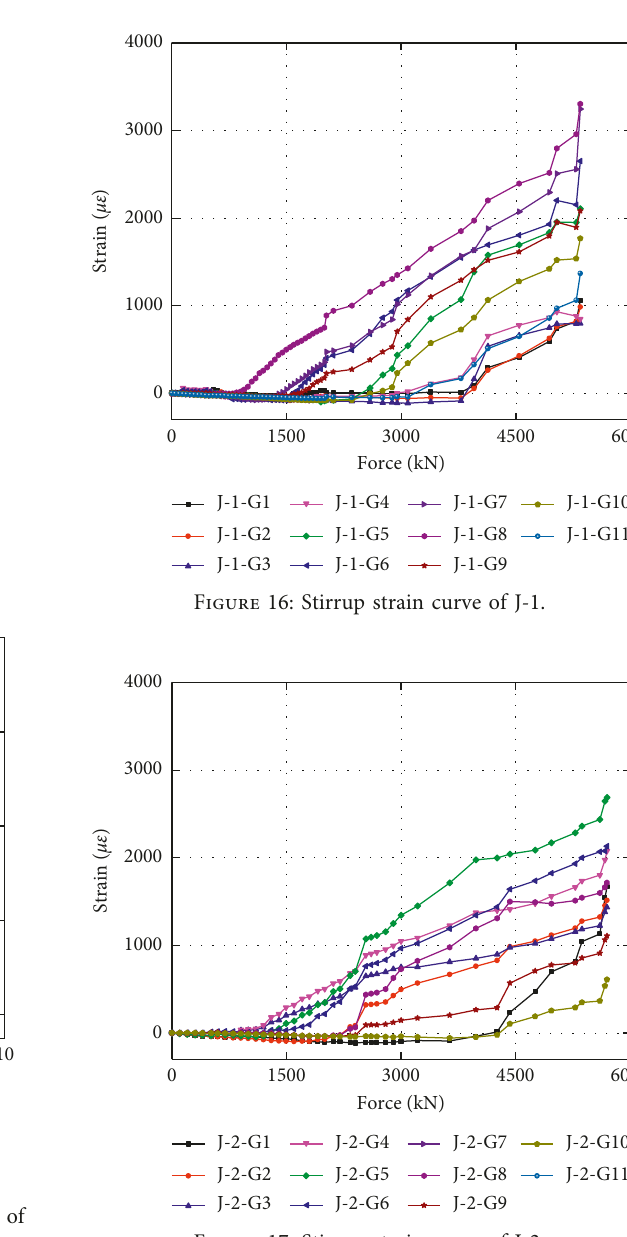
Figure 17: Stirrup strain curve of